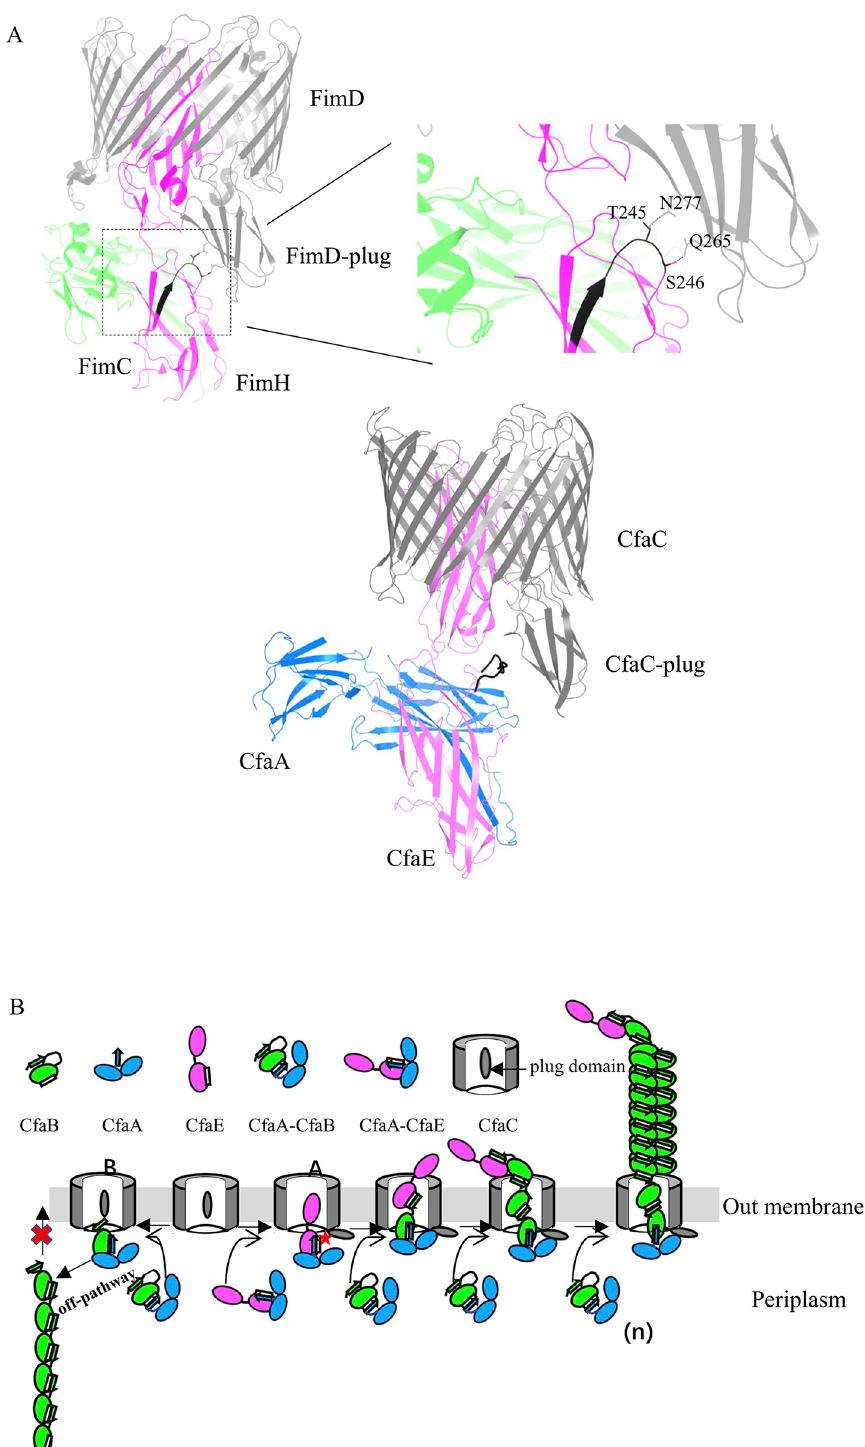
Fig 6. A model of chaperone-adhesin/usher controlled CFA/I fimbriae assembly. (A) Top panel: interaction of T245 and S246 in the flexible loop of FimH with N277 and Q265 of the plug domain of FimD revealed in the crystal structure of the quaternary complex of FimD, FimC and FimH (PDB:3RFZ)[38]. FimD, FimC and FimH are in light gray, light green and bright red, respectively. Bottom panel: model of the CfaA (blue)-CfaE(magenta)-CfaC (grey) quaternary complex based on PDB 3RFZ. The functional loops (residues R311-I320 in CfaE, residues L239-S246 in